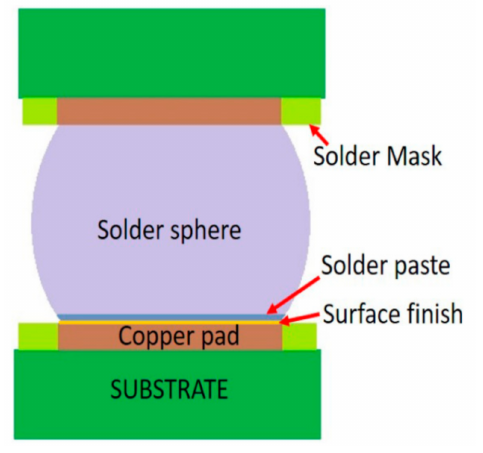
Figure 11. Typical solder